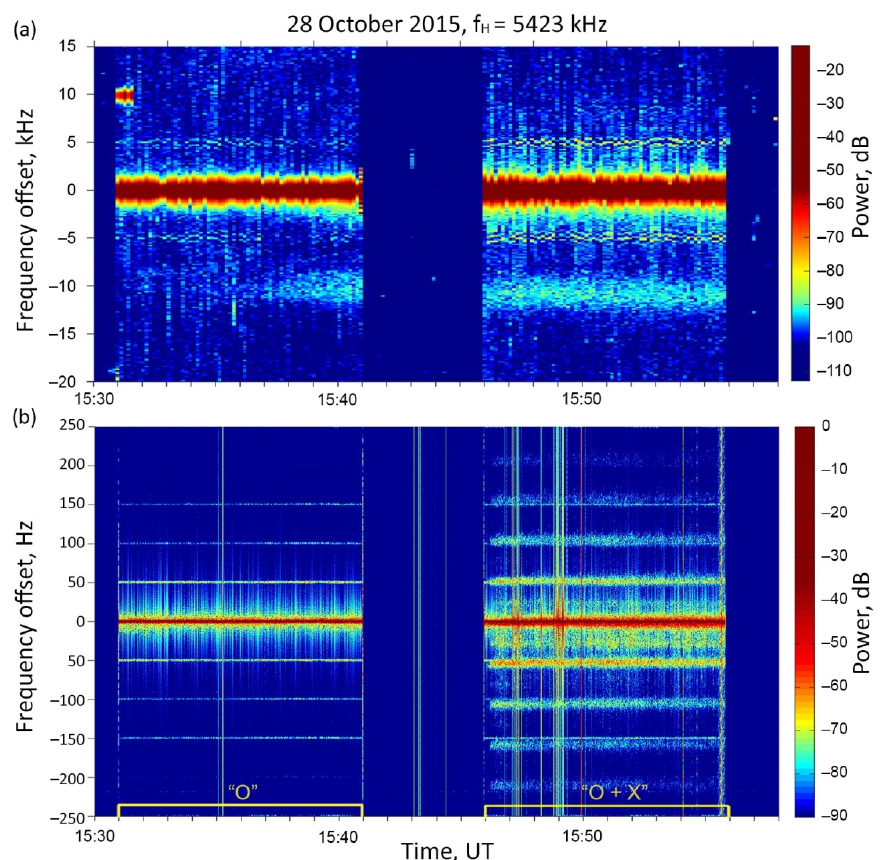
Figure 2. The spectrogram of ( a ) the wideband stimulated electromagnetic emission (WSEE) recorded in the close vicinity of the EISCAT/heating facility and ( b ) narrowband stimulated electromagnetic emission (NSEE) was observed at a distance of 1200 km from the heating facility in the course of the experiment on 28 October 2015 at a pump frequency f H = 5.423 MHz. The almost “pure” O-mode wave was radiated with effective radiated power of 362.4 MW from 15:31 to 15:37 UT and then reduced to 236.9 MW from 15:37 to 15:41 UT. The simultaneous radiation of 29.9 MW (20% of full ERP ) with the O-mode pump wave and 130.5 MW (80% of full ERP ) with the X-mode wave was made from 15:46 to 15:56 UT. The pump pulses and polarization of the heater wave are shown on the time axis.